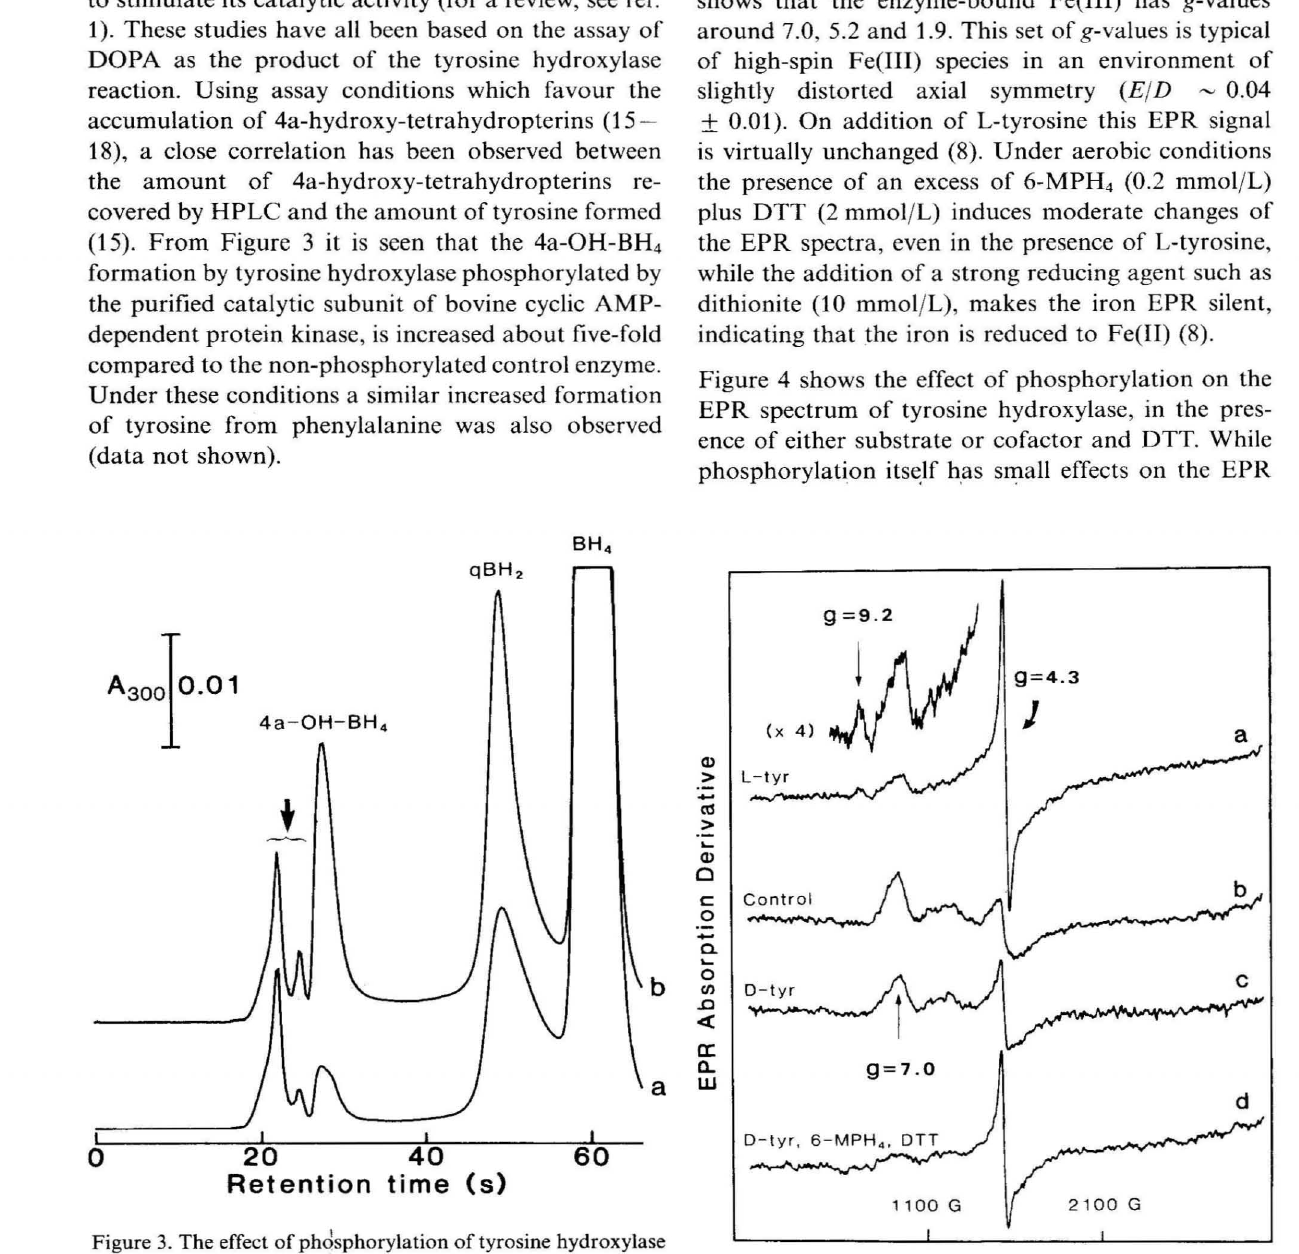
Figure 4. EPR spectra of phosphorylated tyrosine hydroxylase. (a) After incubation with 1.5 mmol/L L-tyrosine, (b) only standard incubation medium (control), (c) after incubation with 1.7 mmol/L D-tyrosine, and (d) after incubation with 1 mmol/L not corrected for the small dilution upon adding substrate or cofactor (7% dilution in Figs. 4a and 4c, 9% dilution in Fig. 4d); pH was kept between 7.0 and